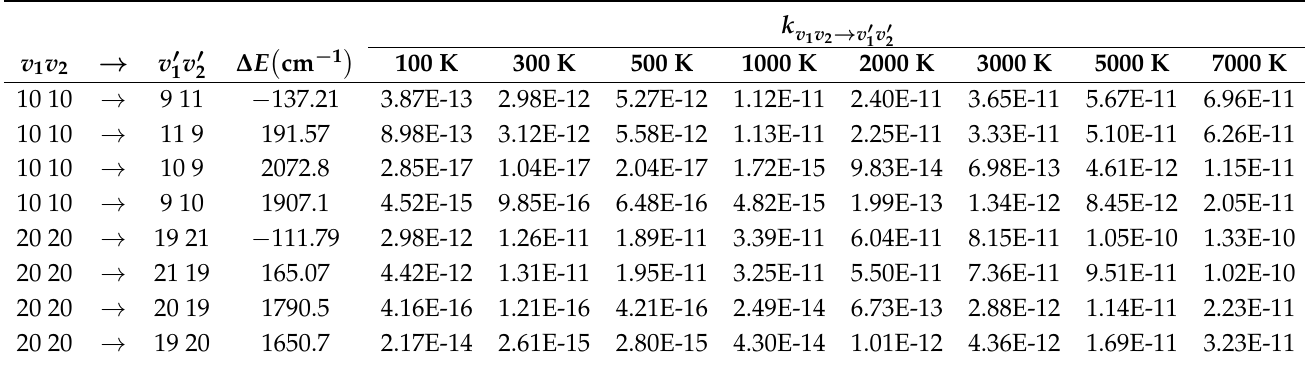
) + N ( v (cid:48) ) + ∆ E . 2 2 1